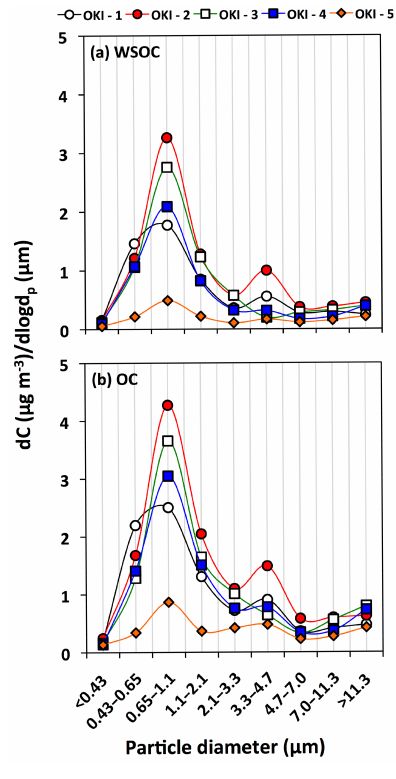
Figure 6. Size distributions of water-soluble organic carbon (WSOC) and organic carbon (OC) in the aerosol samples collected on Okinawa